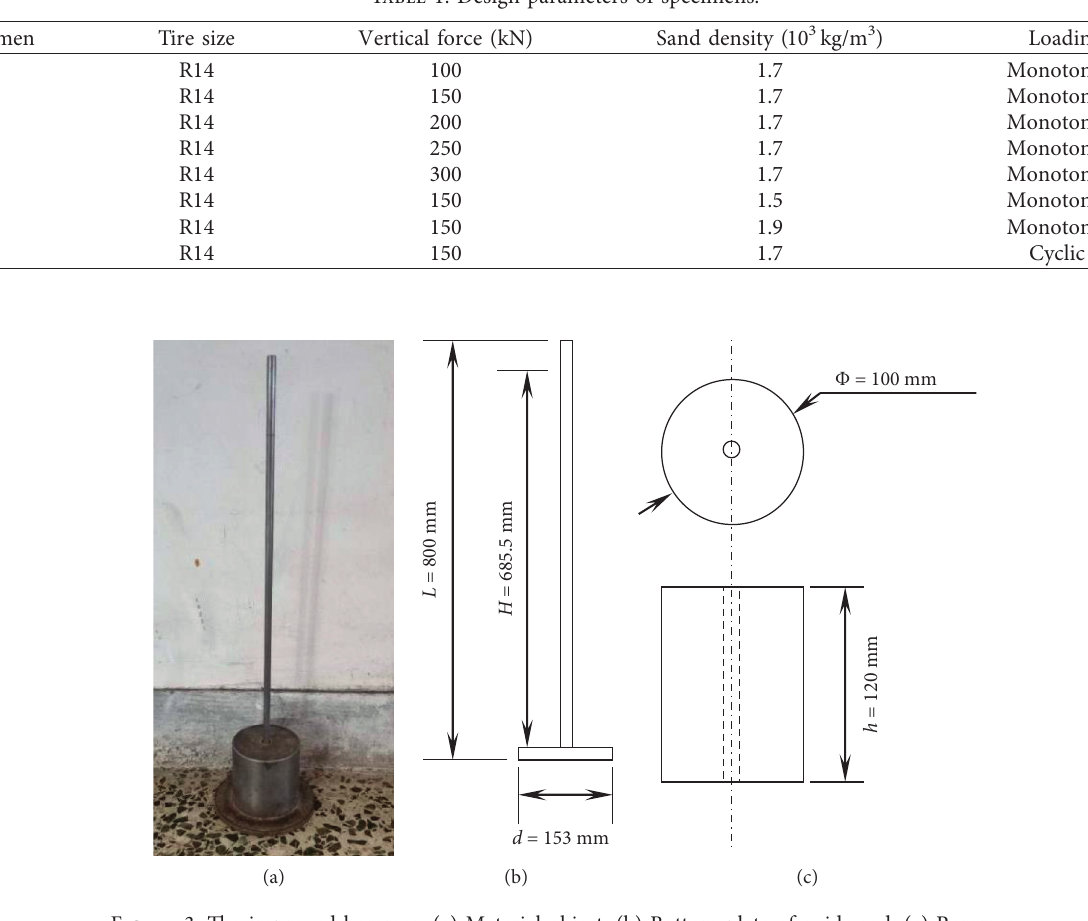
Figure 3: The improved hammer. (a) Material object. (b) Bottom plate of guide rod. (c) Rammer.